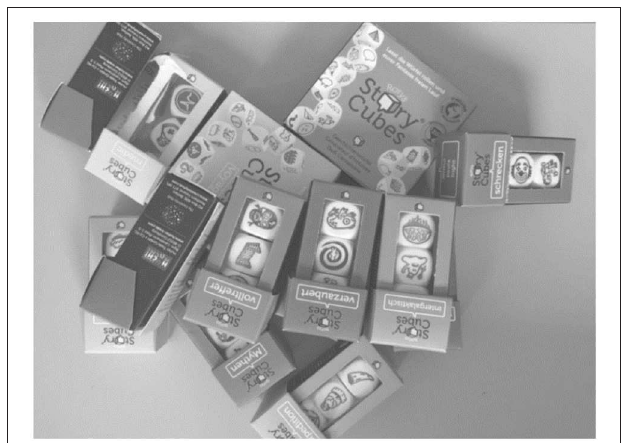
FIGURE 2 | Story cubes, dice with pictograms to stimulate storytelling.